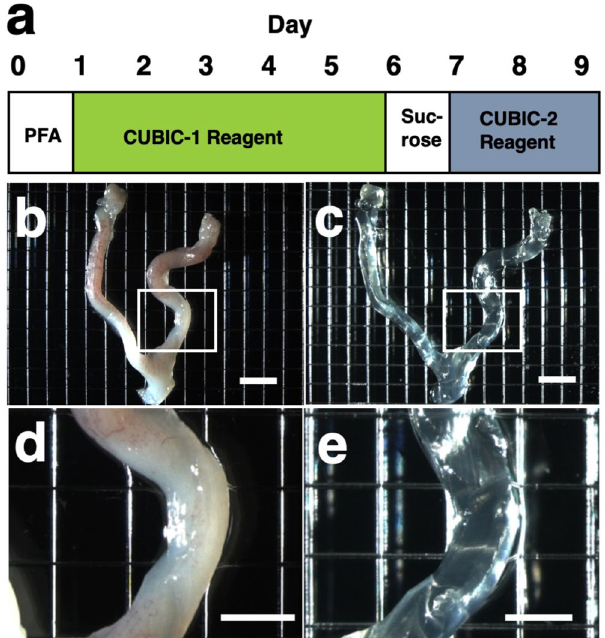
Figure 1. Tissue clearing of the uterus using CUBIC. ( a ) CUBIC protocol for the non-pregnant uterus. ( b , c ) Bright-field images of the uterus of wild-type adult mice before ( b ) and after ( c ) tissue clearing. ( d ) A highly magnified image within the white square of (b ). ( e ) A highly magnified image within the white square of ( c ). Scale bars, 4 mm ( b,c ) and 2 mm ( d,e